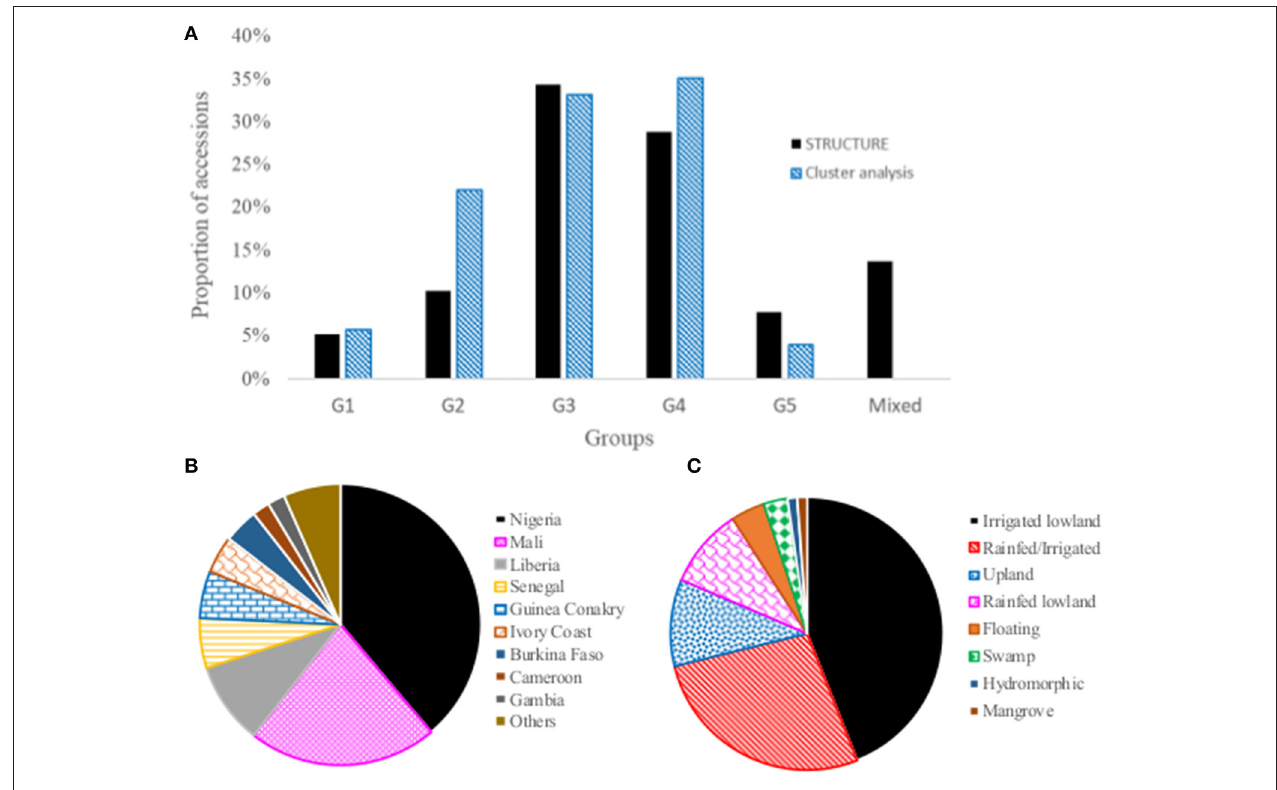
FIGURE 7 | The distribution of accessions selected to represent mini-core collection by (A) groups predicted based on STRUCTURE and cluster analysis; (B) countries of origin, and (C) adaptation ecologies. See Supplementary Table S1 for